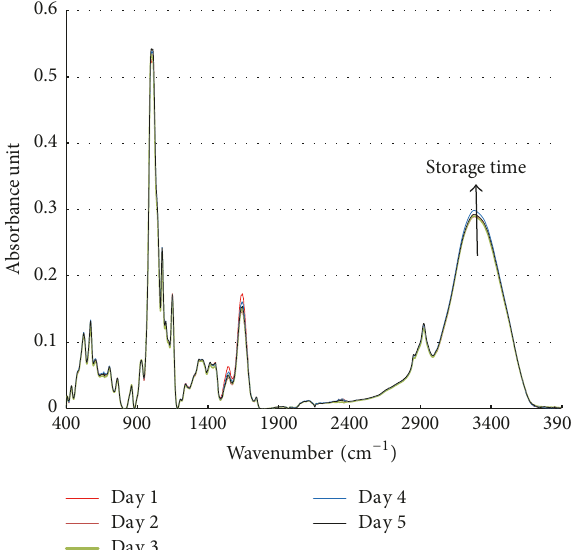
Figure 7: Mean spectra of the normalized bread spectra over 5 days of storage in frozen condition.